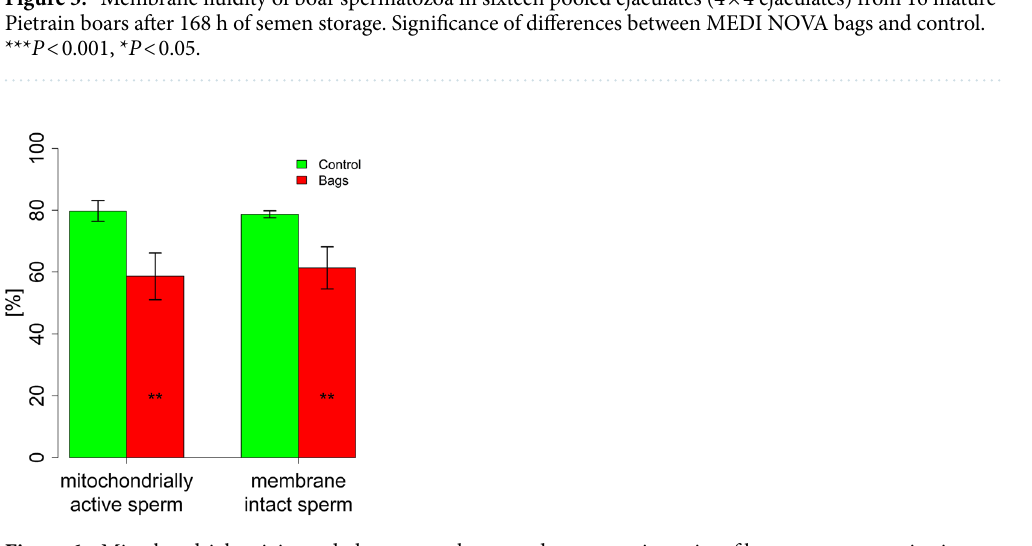
Figure 6. Mitochondrial activity and plasma membrane and acrosome integrity of boar spermatozoa in sixteen pooled ejaculates (4 × 4 ejaculates) from 16 mature Pietrain boars after 168 h of semen storage. Significance of differences between MEDI NOVA bags and control. * P < 0.05.